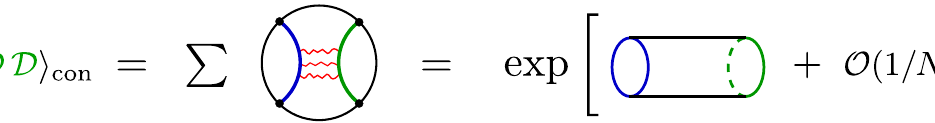
Figure 2 . The connected four-point function of determinant operators. On the AdS side, it is given by a sum of exchanges of closed string states. The leading contribution at large N can be computed by exponentiating the cylinder partition